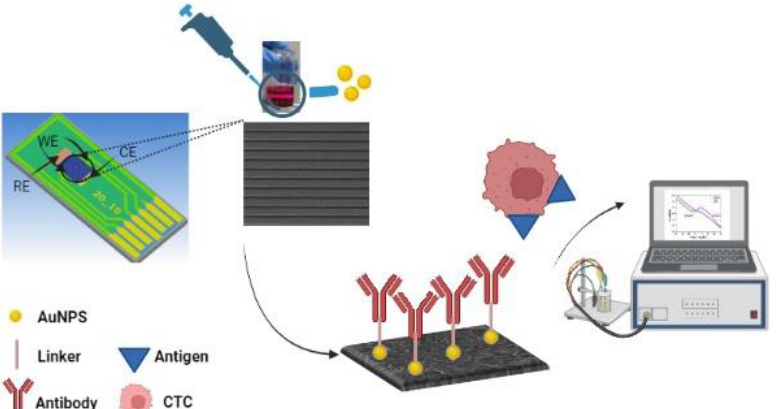
Figure 3. Electrochemical sensor: schematic presentation of the procedure of functionalizing the VG-based electrochemical biosensor and tumor cells’ capture and detection.